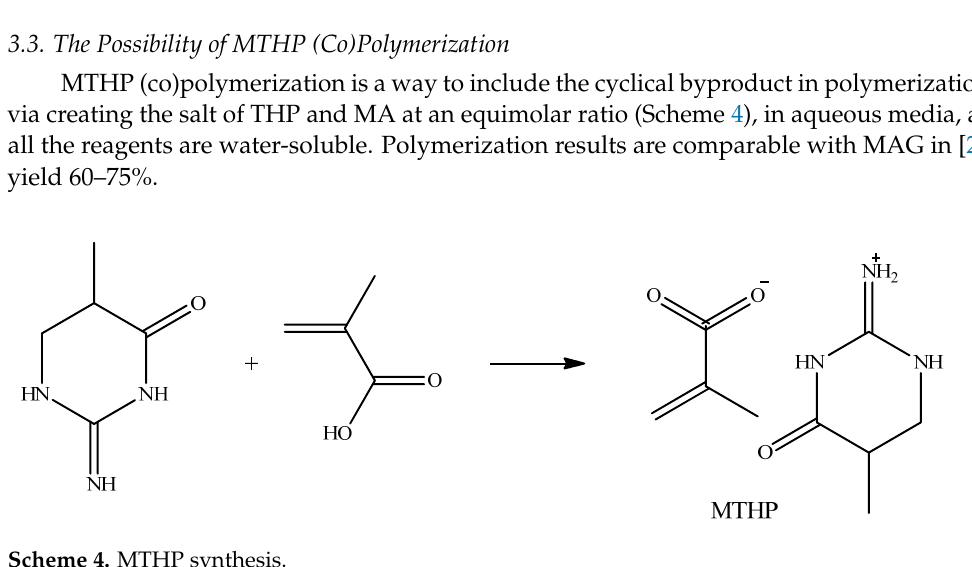
Table 4. Composition and yield of MTHP (co)polymerization products with MA and